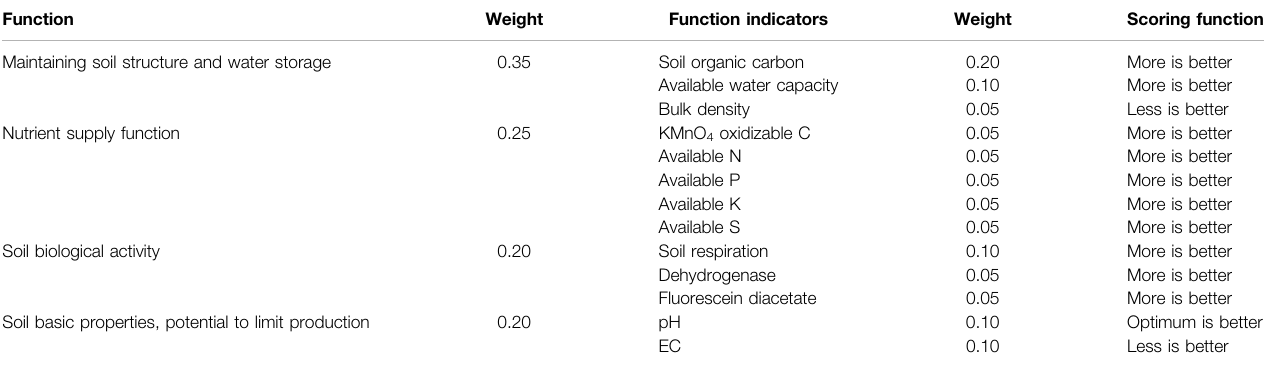
TABLE 1 | Soil functions, their indicators, and assigned weights. Function